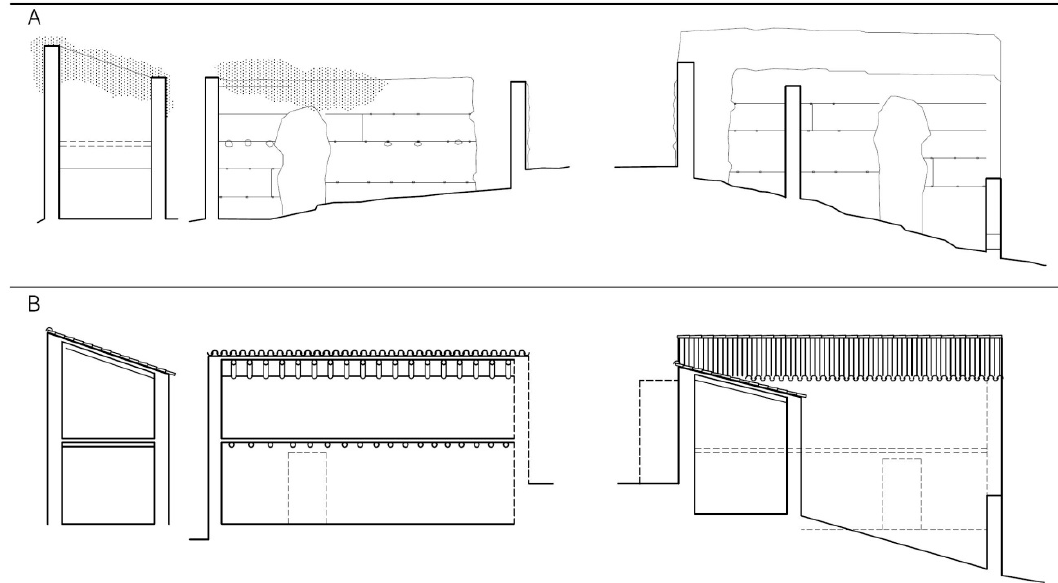
Figure 9. ( A ): The ruinous current state. ( B ): The graphic restitution of ancient architecture.